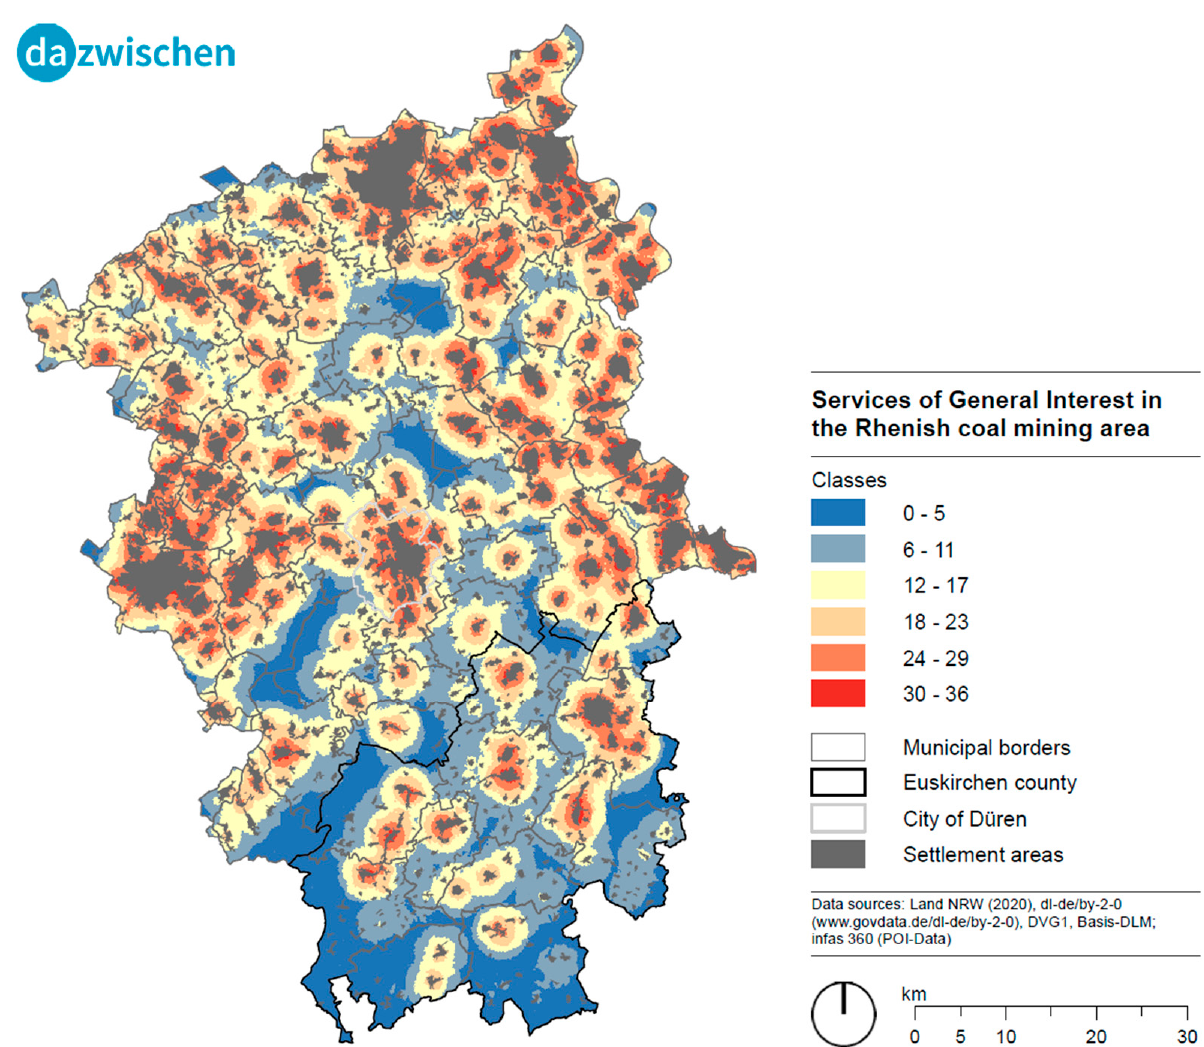
Figure 6. Analysis of accessibility to SGI in the Rhenish coal-mining area. Source: own figure. Broadband